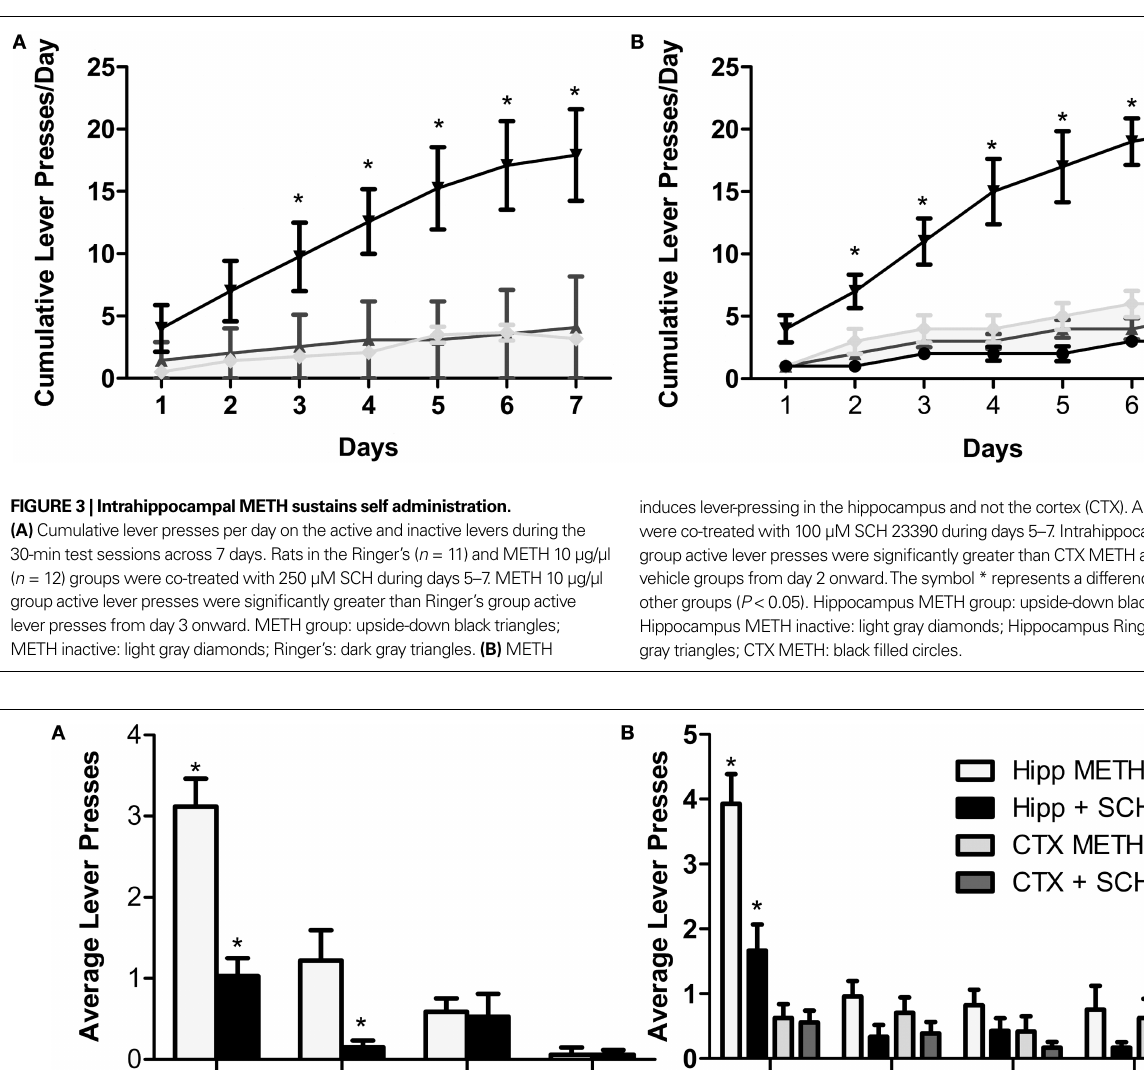
FIGURE 4 | Intrahippocampal METH self administration is modulated via local D /D receptors. (A) Average lever presses on the active and inactive 1 5 levers during the 30-min test sessions across 7 days. Rats in the Ringer’s ( n = 12) and METH 10 µg/µl ( n = 17) groups were co-treated with 250 µM SCH 23390 during days 5–7 (black bars). METH group active lever presses were signifi cantly greater than Ringer’s group active lever presses. Local application of